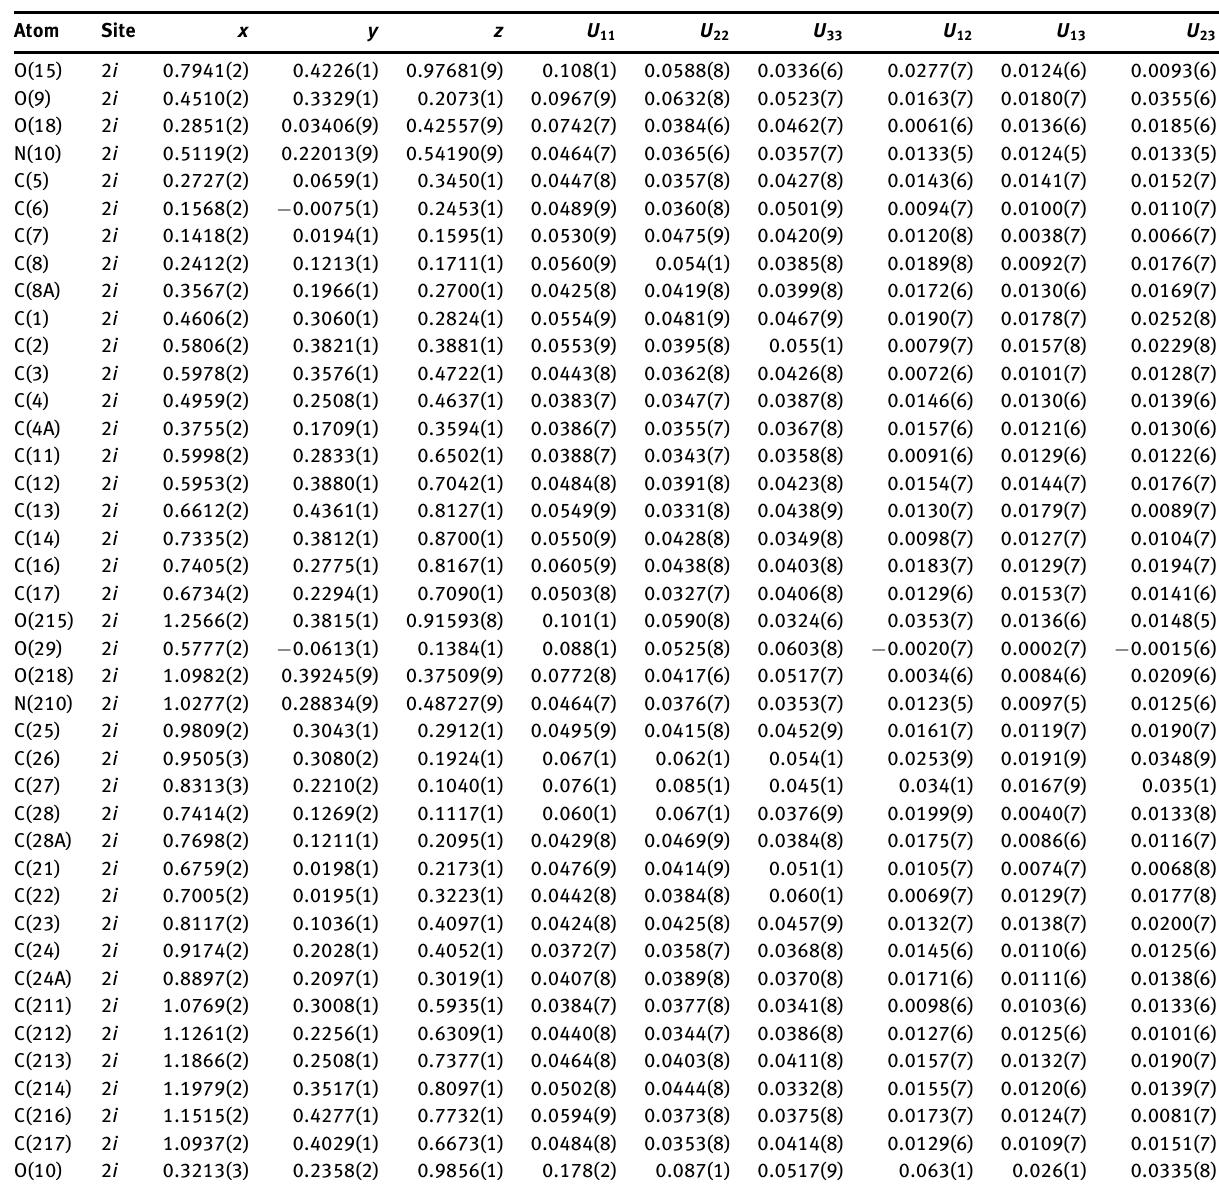
Table 3: Atomic displacement parameters (Å 2